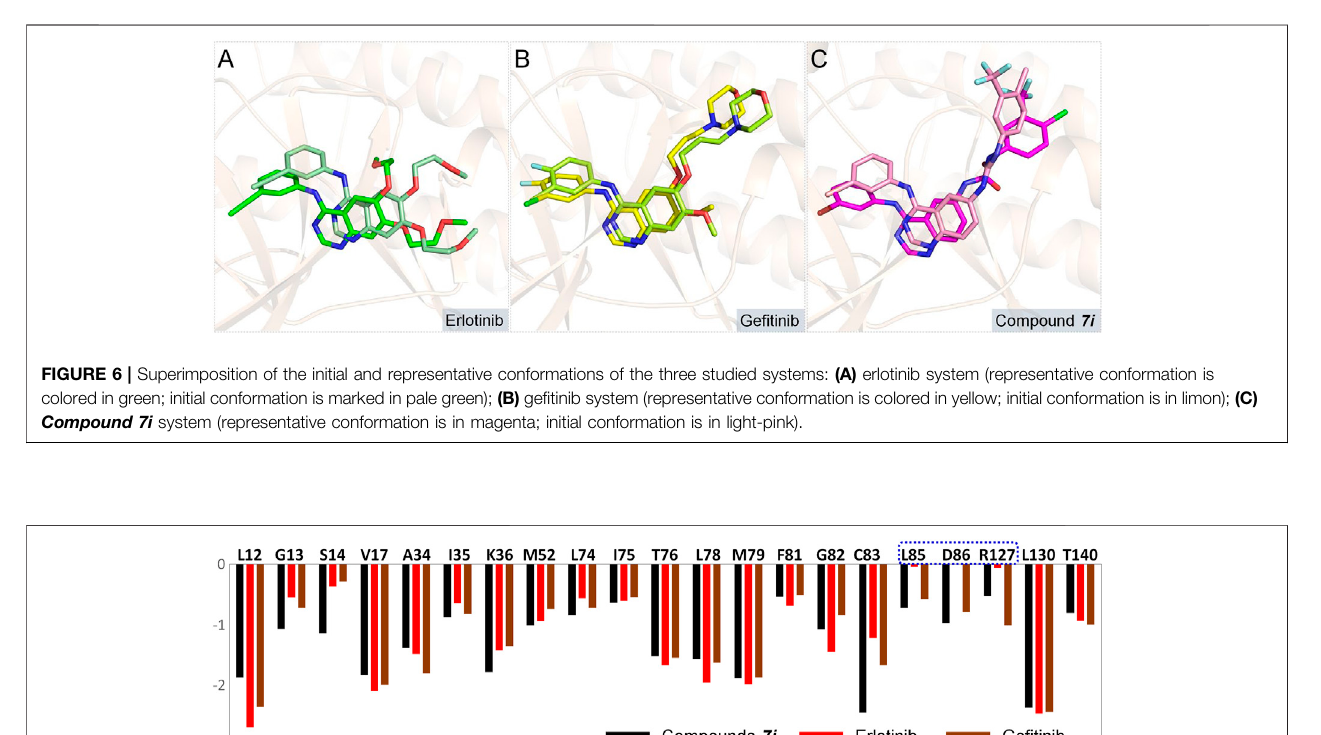
anilinoquinazoline fragment surrounded by three β -sheets and two loop domains.